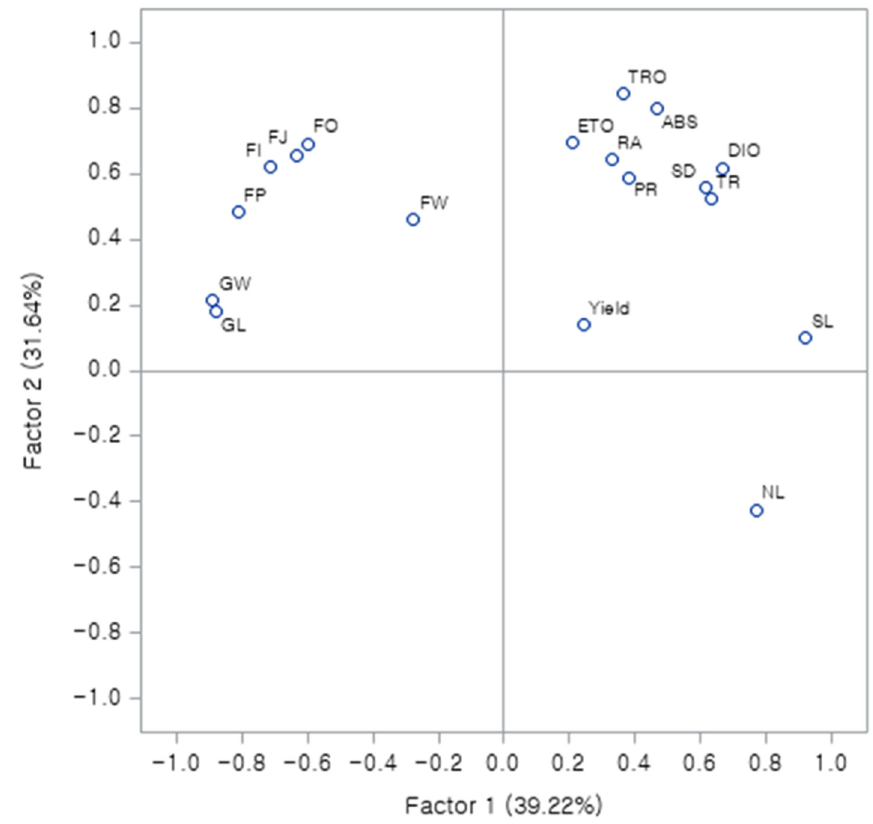
Figure 8. Biplot of the principal component analysis (PCA) of yield, photosynthetic parameters, chlorophyll- a fluorescence parameters, and vegetative parameters of cut rose flowers grown in the greenhouse during the summer season. The two principal components (PC1 and PC2) disclosed 70.86% of the total variation related to one scion, three rootstocks, and three grafted cut rose flowers. ABS: ABS/RC; DIO: DI 0 /RC; ETO: ET 0 /RC; TRO: TR 0 /RC; FO: F O ; FJ: F J ; FI: F I ; FP: F P ; FW: flesh weight; GL: guard cell length; GW: guard cell width; NL: number of leaves; PR: photosynthesis rate; RA: root activity; SD: stomatal conductance; SL: stem length; TR: transpiration rate.